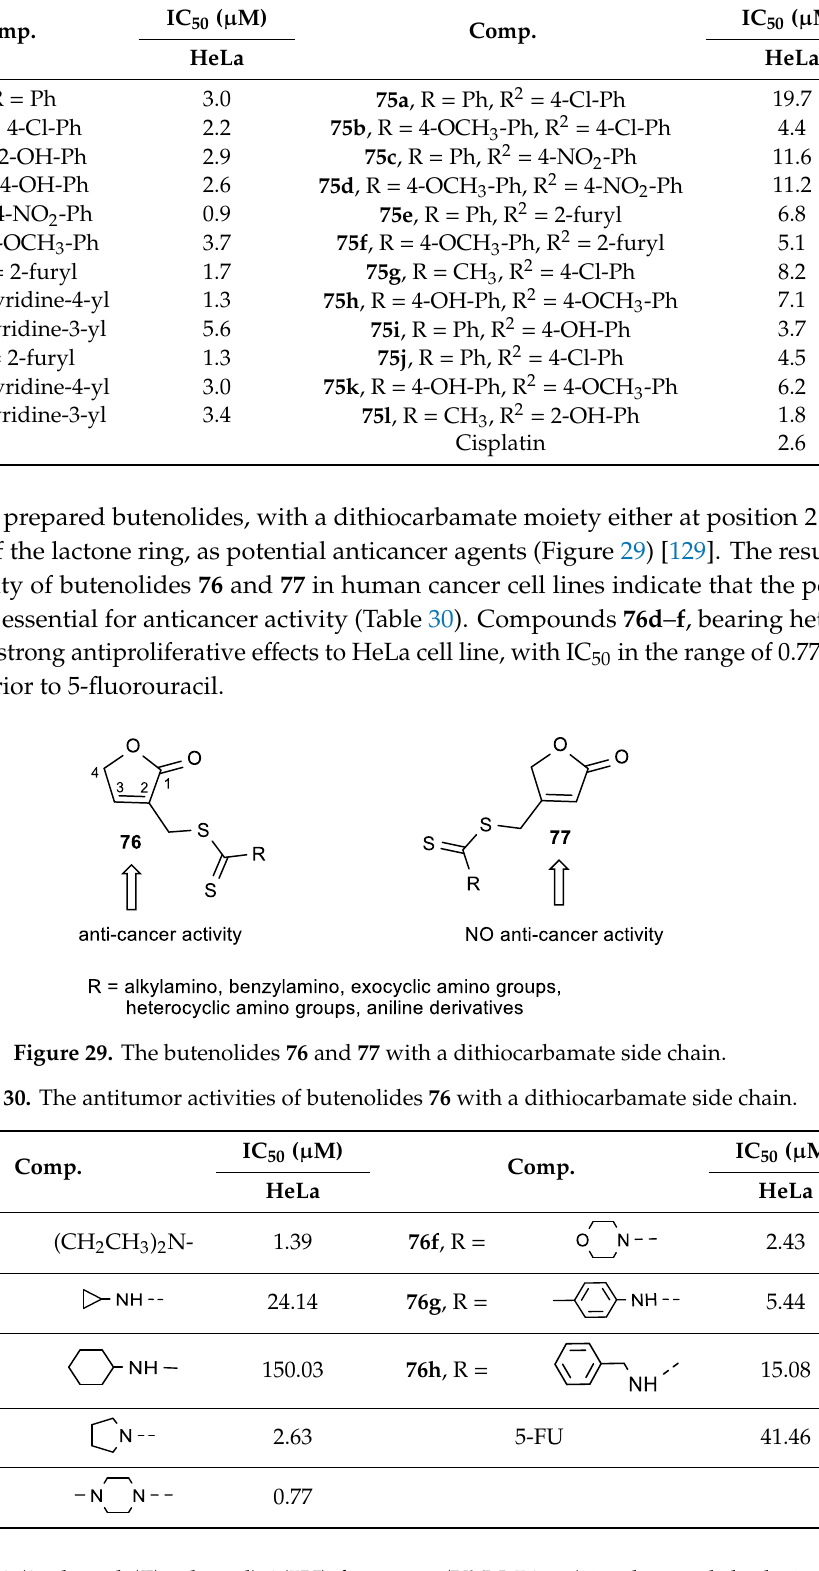
Figure 28. Butenolides substituted with 1,3,4-thiadiazoles ( 74a – l ) or 1,2,4-triazole Schiff bases ( 75a – l ) at position C-3 of the lactone ring. Table 29. The antproliferative effect of butenolides substituted with 1,3,4-thiadiazoles ( 74a – l ) or 1,2,4-triazole Schiff bases ( 75a – l ) on HeLa cell line. Comp.